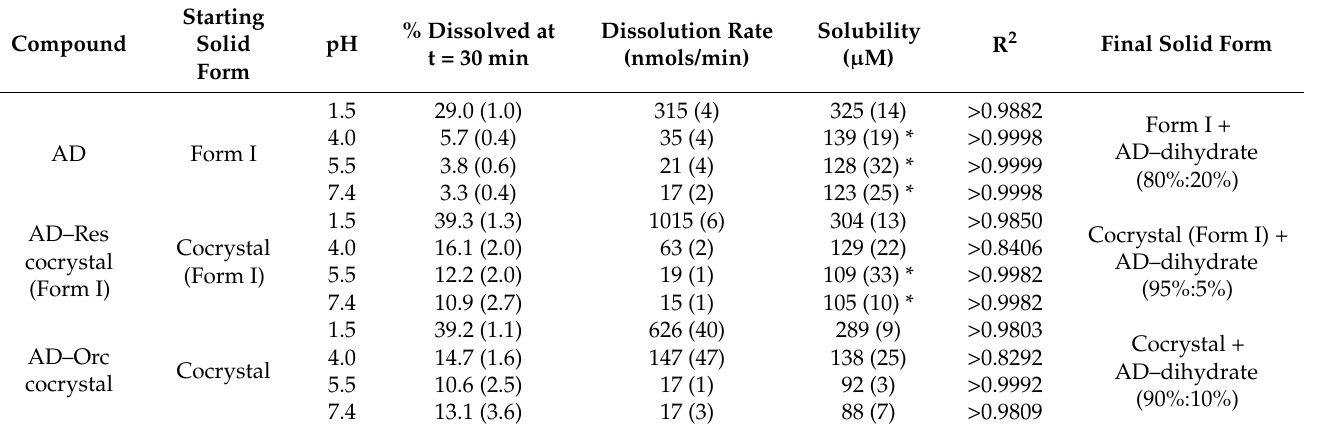
Table 3. Percentage of dissolution and dissolution rate (nmols min − 1 ) of AD and the cocrystals at different GIT pH values. AD solubility ( µ M) and the solid forms observed in the tablet surface after the dissolution measurements are also provided. Standard deviation is shown in parenthesis ( n = ·